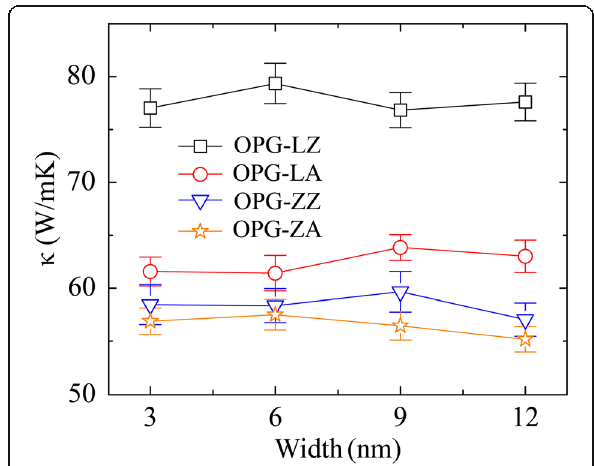
Fig. 3 TC of OPG-L and OPG-Z as a function of width